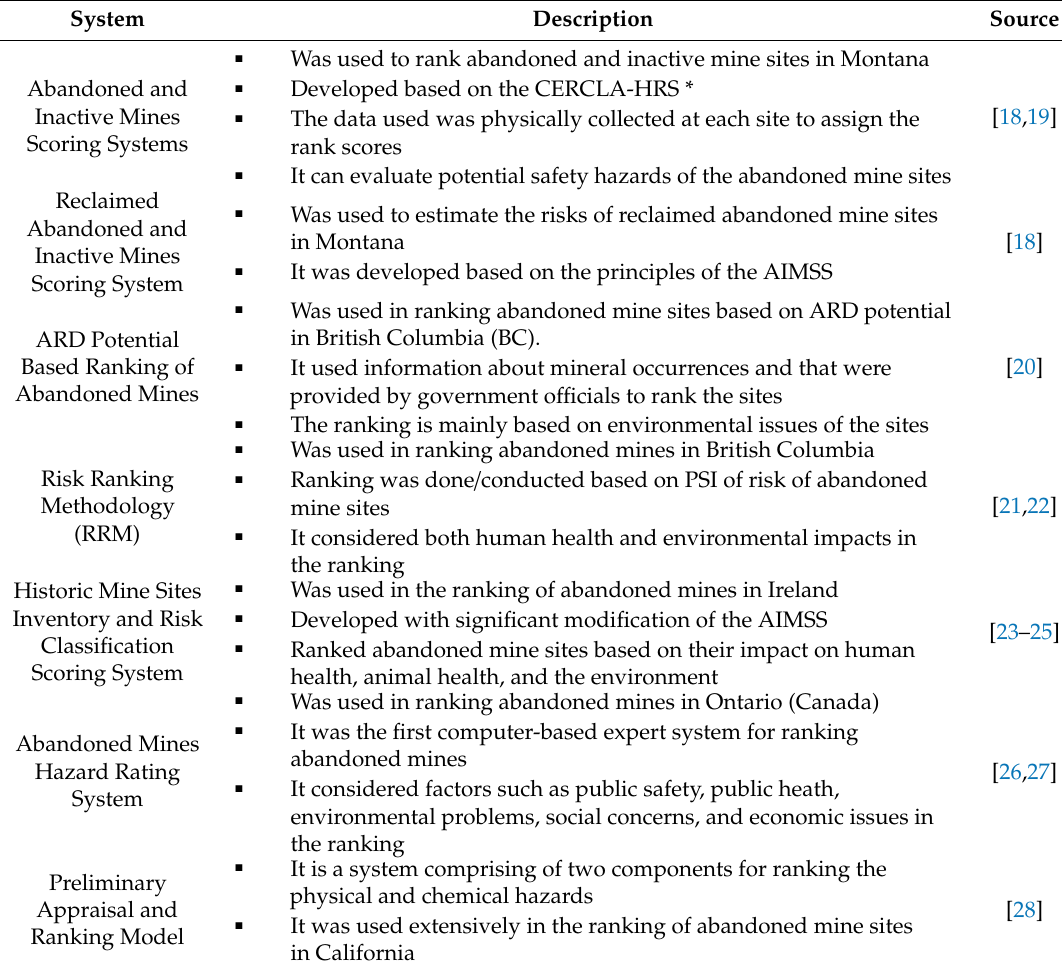
Table 1. Description of the popular ranking systems for abandoned mine sites [15]. Description